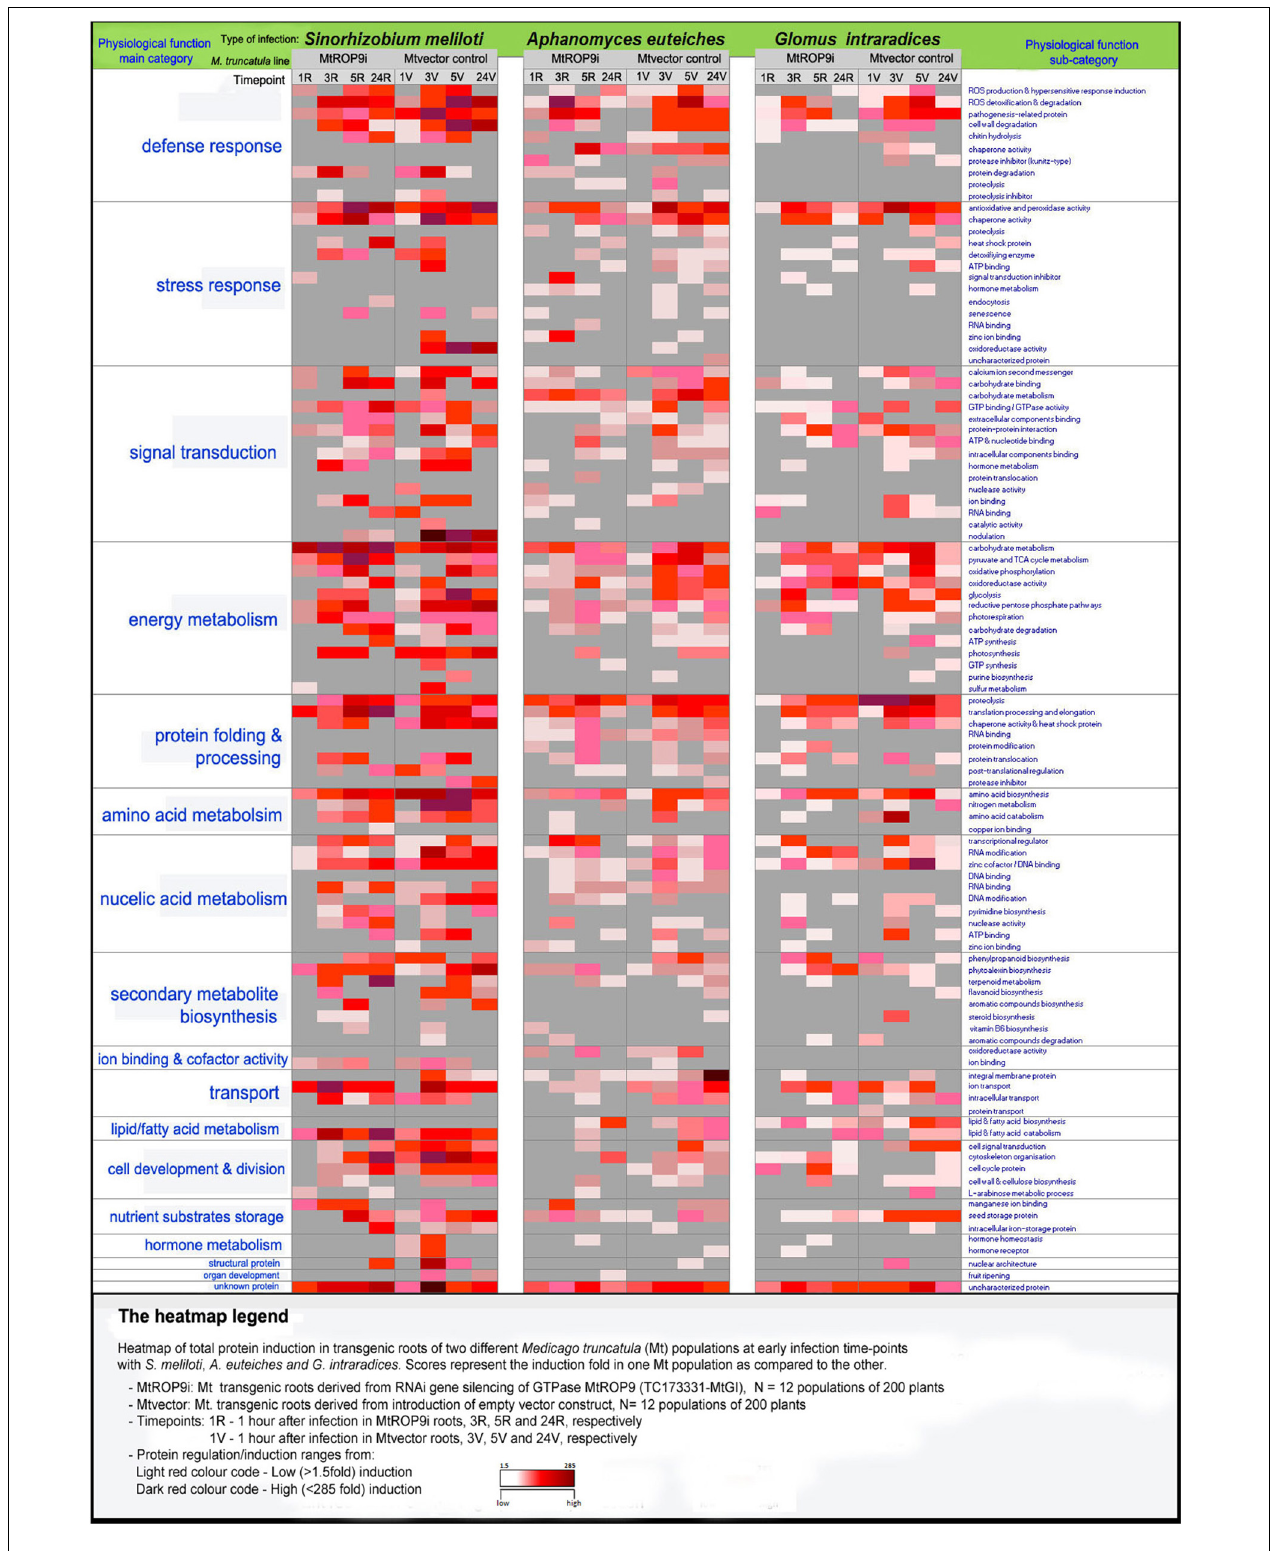
FIGURE 2 | The heatmap